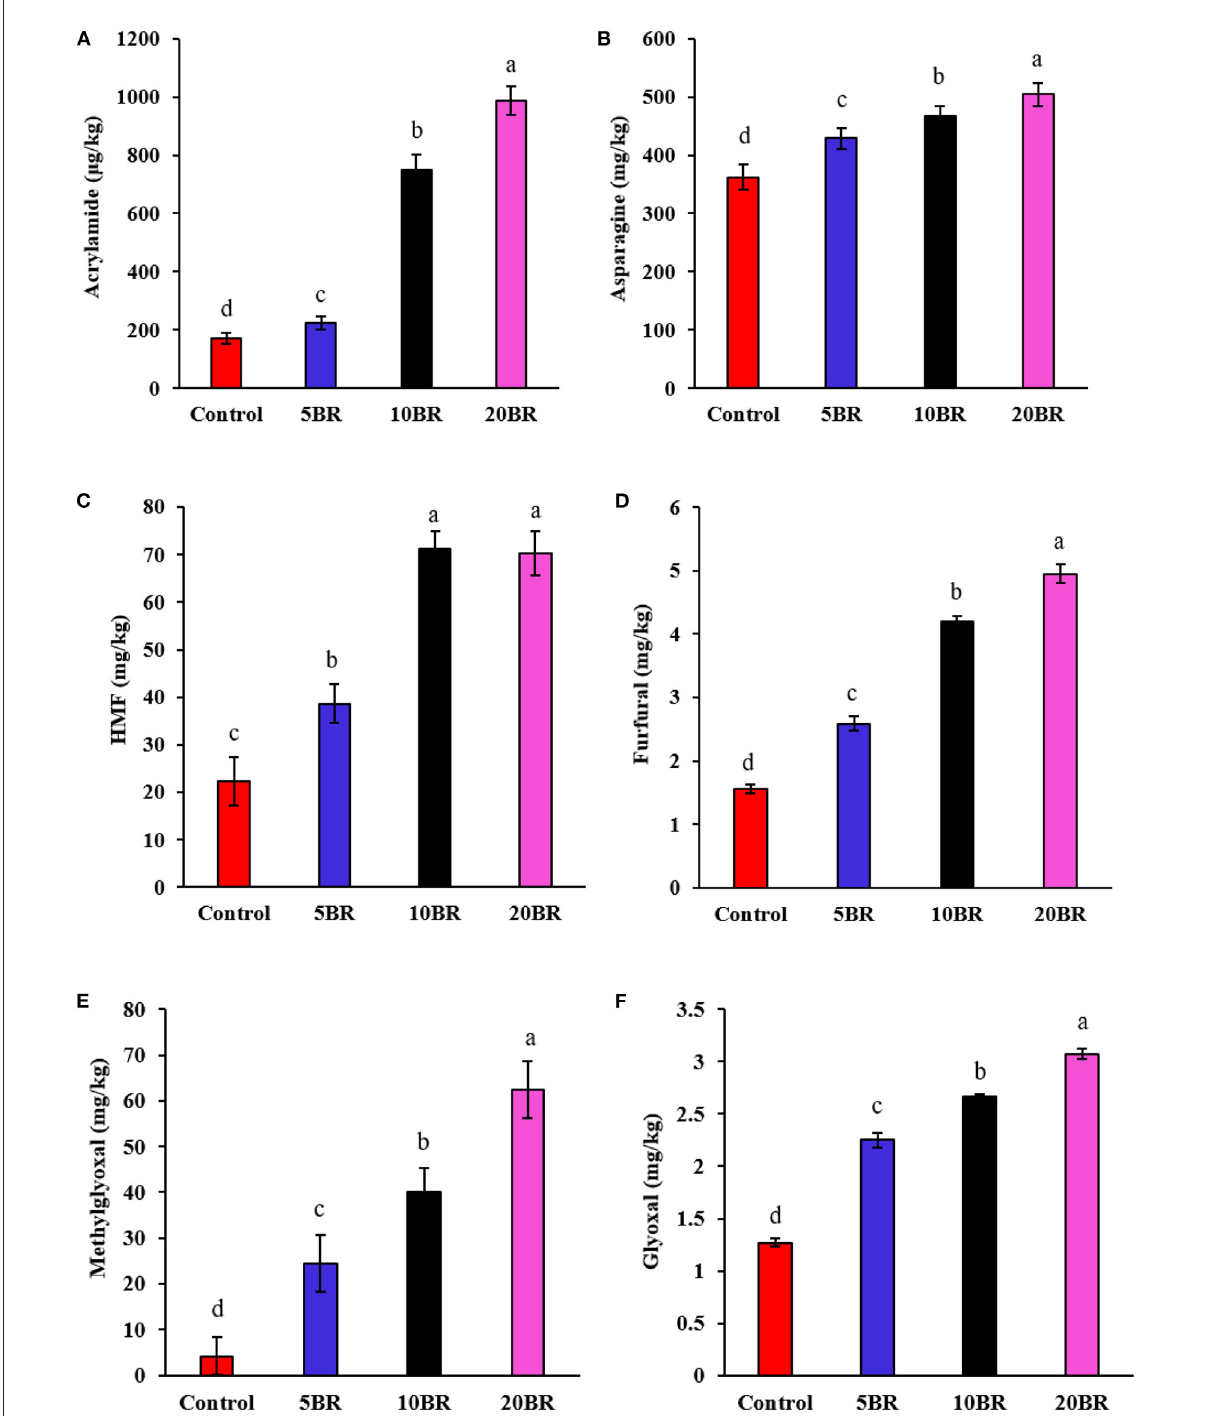
FIGURE5 Content of asparagine, acrylamide, HMF, furfural, methylglyoxal, and glyoxal in flaky rolls incorporated with different proportions of black rice flour: (A) acrylamide content; (B) asparagine content; (C) HMF content; (D) furfural content; (E) methylglyoxal (MGO) content; and (F) glyoxal (GO) content. Different letters significantly represent difference ( P < 0.05) from the